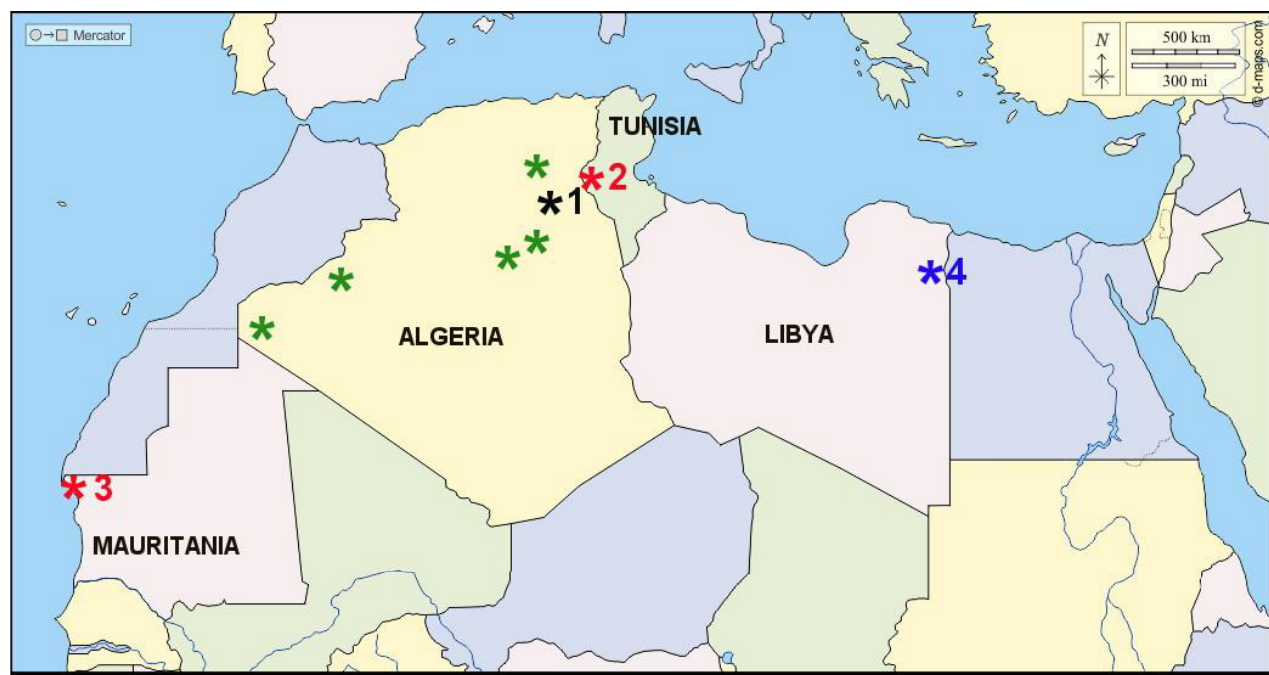
Figure 1. Distribution map of Psammornis localities in North Africa: black star (1) — type locality of Psammornis rothschildi Andrews, near Touggourt, Algeria; red stars — localities with Psammornis eggshells in situ in a stratigraphic context: 2 — Segui Formation (latest Miocene), Chebket Safra near Moulares, south-western Tunisia, 3 — Aguerguerian (Middle Pleistocene), Lévrier Bay area, north-western Mauritania; blue star (4) — type locality of Psammornis libycus Moltoni (a probable synonym of Struthio camelus ), near Giarabub, Libya; unnumbered green stars — Psammornis finds without a stratigraphic context in the Algerian Sahara.